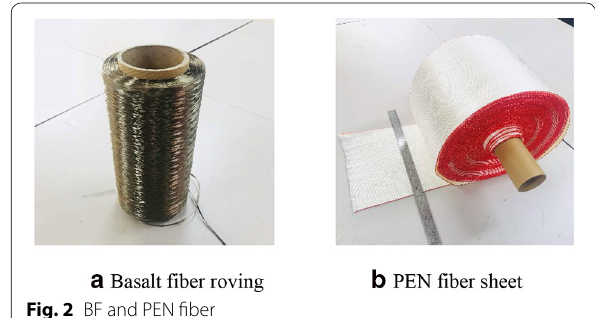
Fig. 2 BF and PEN fiber